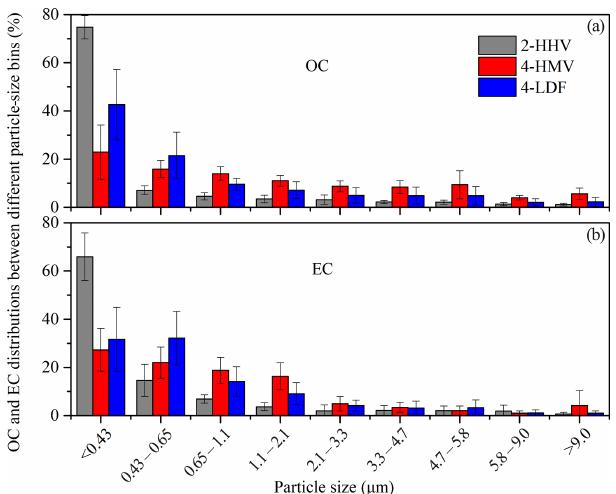
Figure 2. Total OC and EC distributions between different particle- size